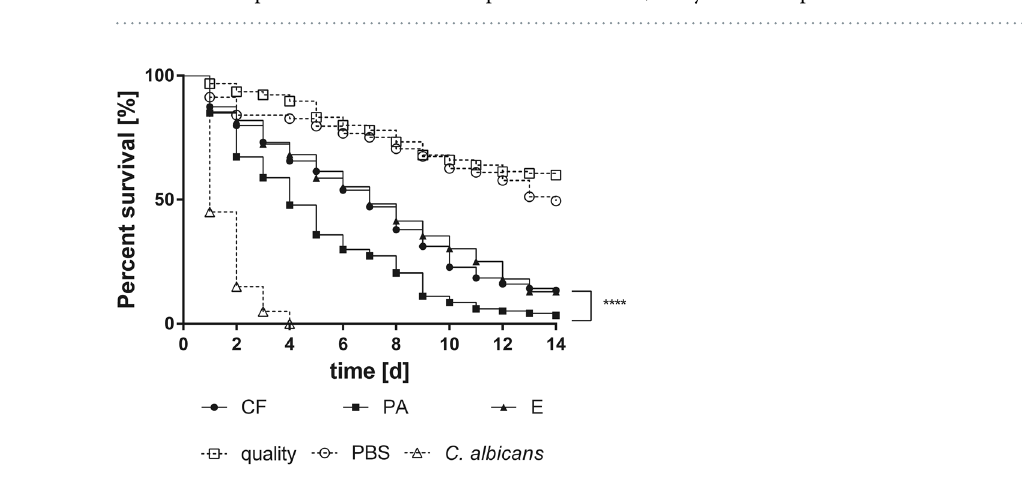
Figure 4. Survival of G. mellonella after infection with wild-type strains of E. dermatitidis from various sources: (a ) Isolates from the environment (E). ( b ) Isolates from cystic fibrosis patients (CF). ( c ) Isolates from systemic infections in patients from Asia (P). C. albicans was used as an infection control, sterile phosphate-buffered saline (PBS) was injected as a non-infection control, and a group of unharmed caterpillars were used as a quality control of the caterpillar population. All tested E. dermatitidis strains exhibited pathogenicity against G. mellonella caterpillars. n = 10 individuals per test were used, every test was repeated 3 times.